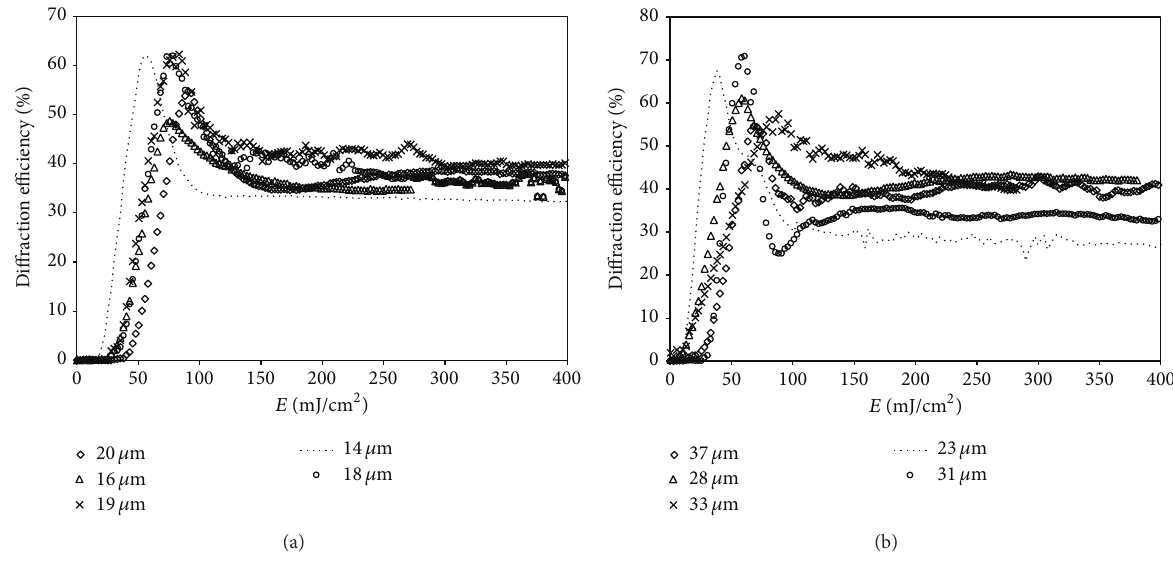
Figure 4: (a) Diffraction efficiency as a function of recording exposure; sample thickness between 14 and 20 𝜇 m using composition 1. (b) Diffraction efficiency as a function of recording exposure; sample thickness between 23 and 37 𝜇 m using composition 2.